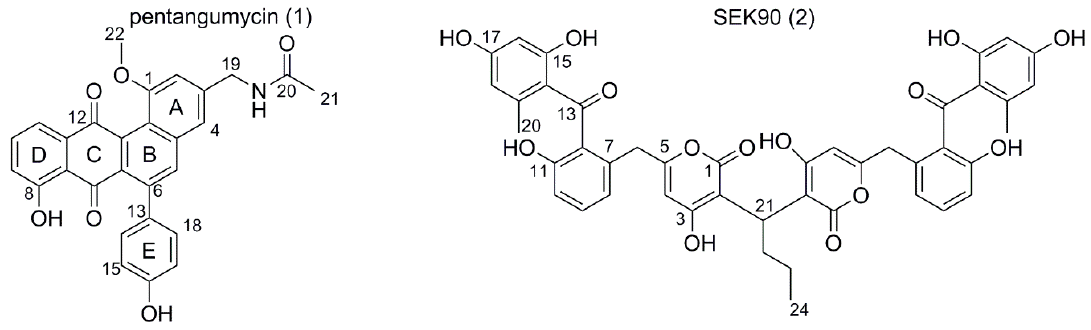
Figure 2. Structural formulas of pentangumycin ( 1 ) and SEK90 ( 2 ).